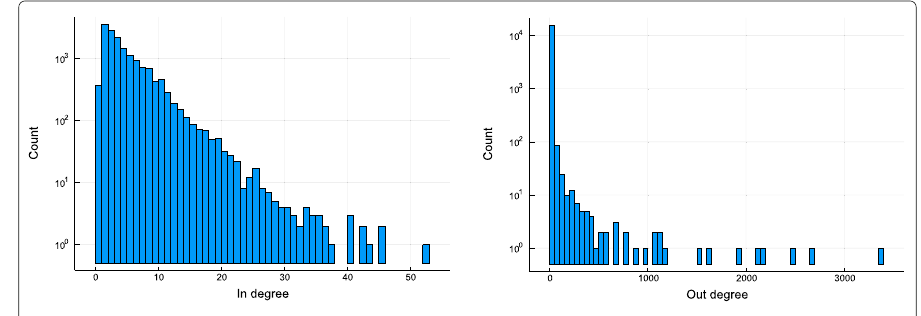
Fig. 5 Cargo degree distributions. In and out degree distributions for the Cargo package